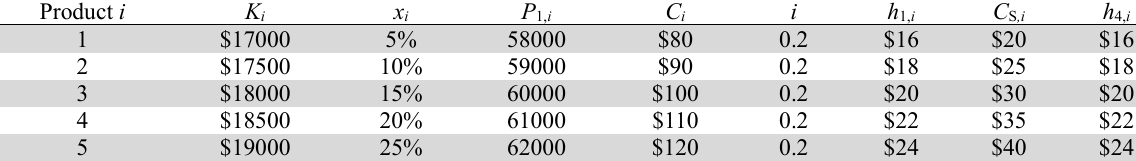
Parameters’ values of the same problem under a single-stage production scheme -1 Product